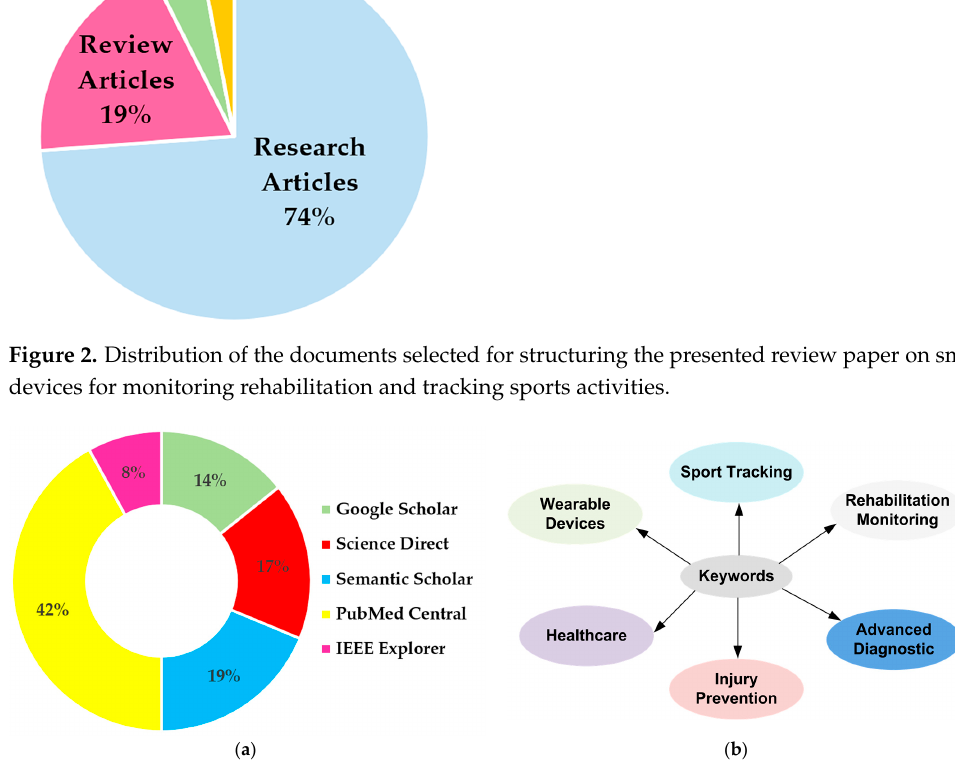
Figure 3. Distribution of the databases ( a ) and main keywords ( b ) used for searching the documents included in this review.